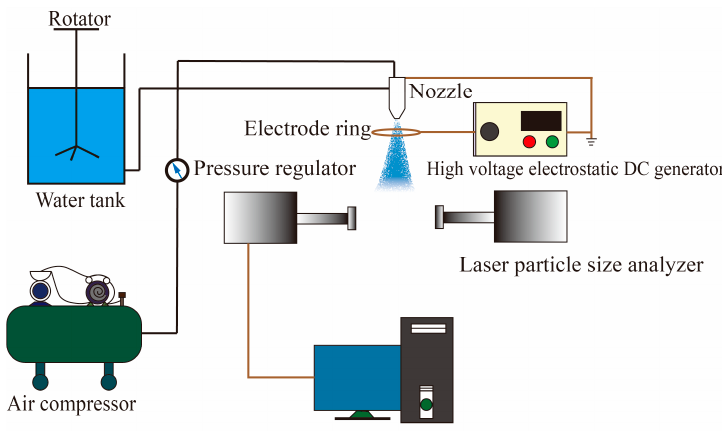
Figure 1. Schematic diagram of the experimental device.